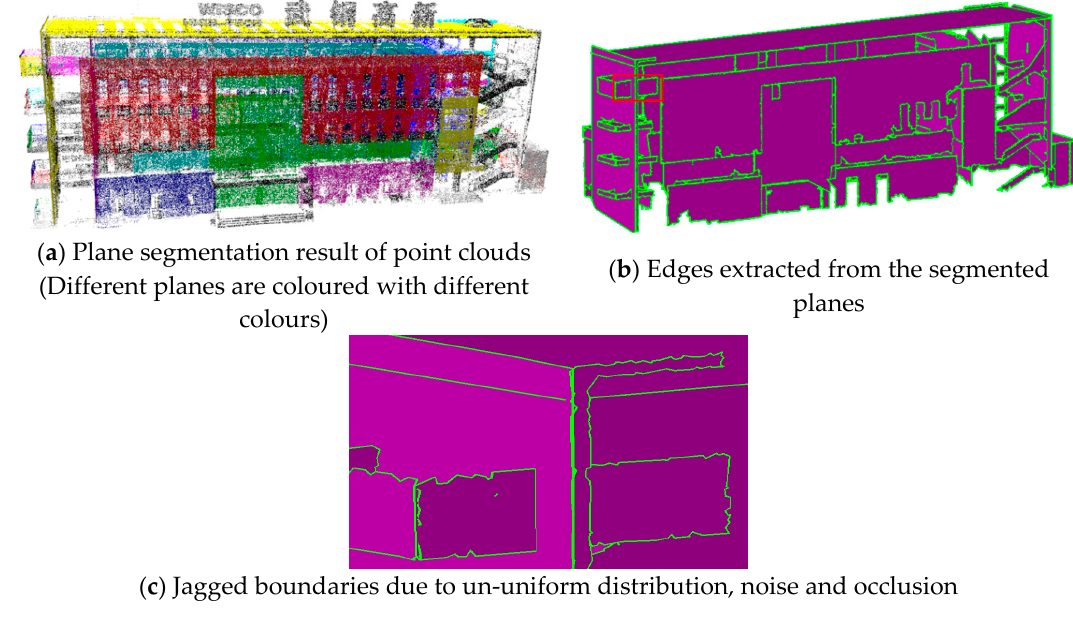
Figure 11. Planar surface extraction result of point clouds.